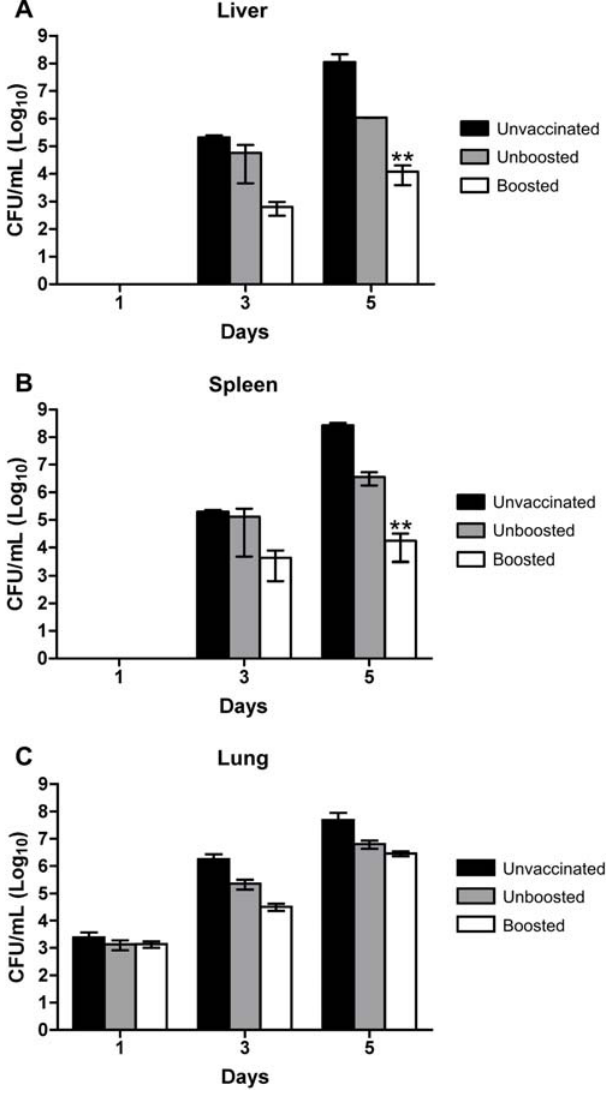
Figure 4. Bacterial burden in mice vaccinated i.n. with Schu S4 D purMCD and challenged with wild-type Schu S4. Mice were unvaccinated, vaccinated (10 4 CFUs), or vaccinated (10 4 CFUs) and boosted (10 6 CFUs) with Schu S4 D purMCD . 42 days post-vaccination, mice were challenged with 100 CFUs of wild-type Schu S4. All vaccinations and challenges were administered by the i.n. route. At one, three, and five days post-challenge, liver, spleen, and lungs from infected animals were aseptically removed and homogenized, and a standard plate count performed on MH containing Amp. The mean and standard errors of CFUs from 3 animals per time point is shown. Asterisks indicate a significantly reduced bacterial burden compared to unvaccinated animals ( P , 0.001 by two-way